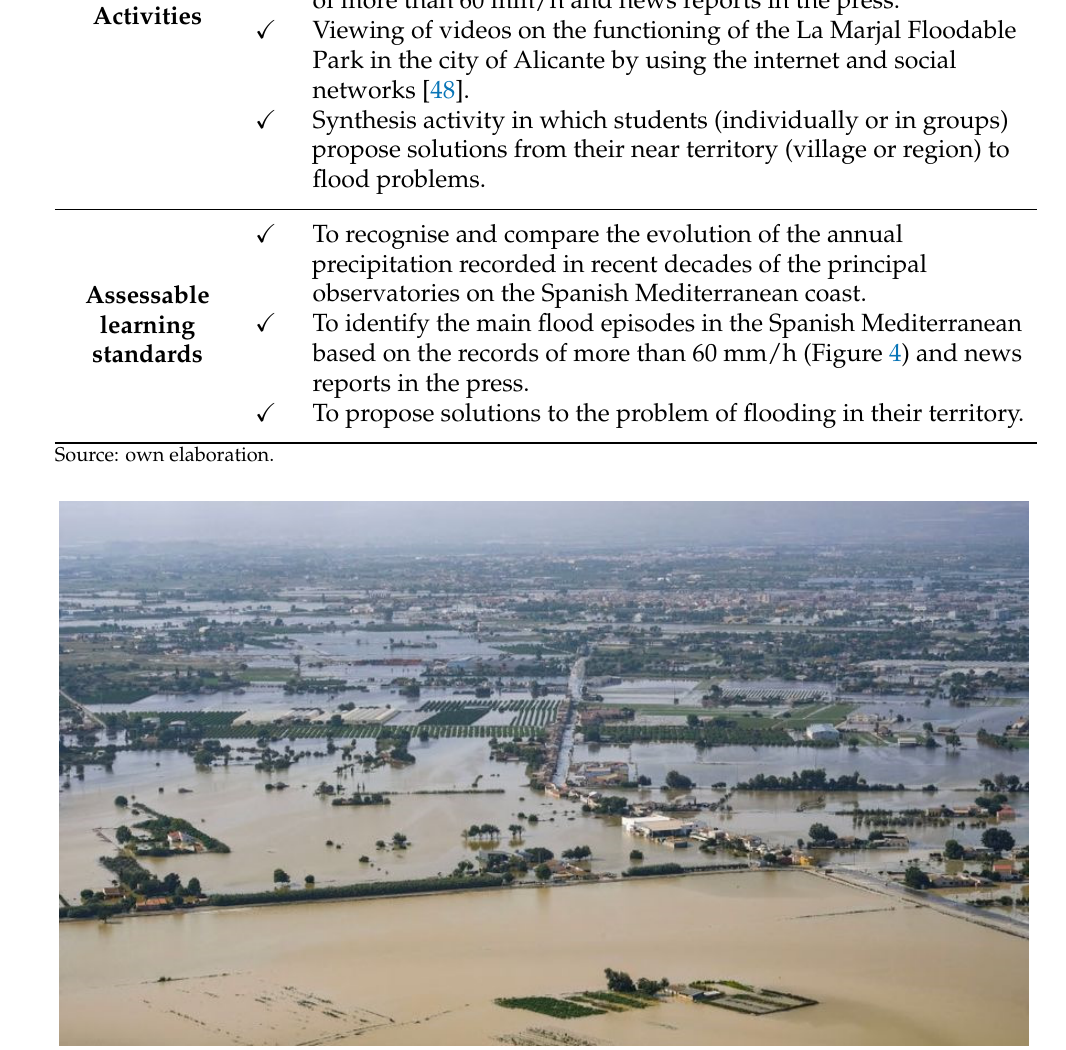
Figure 4. Flood in the Vega Baja of the Segura River (Alicante, Spain), 11–14 September 2019. Source: Generalitat Valenciana [69].